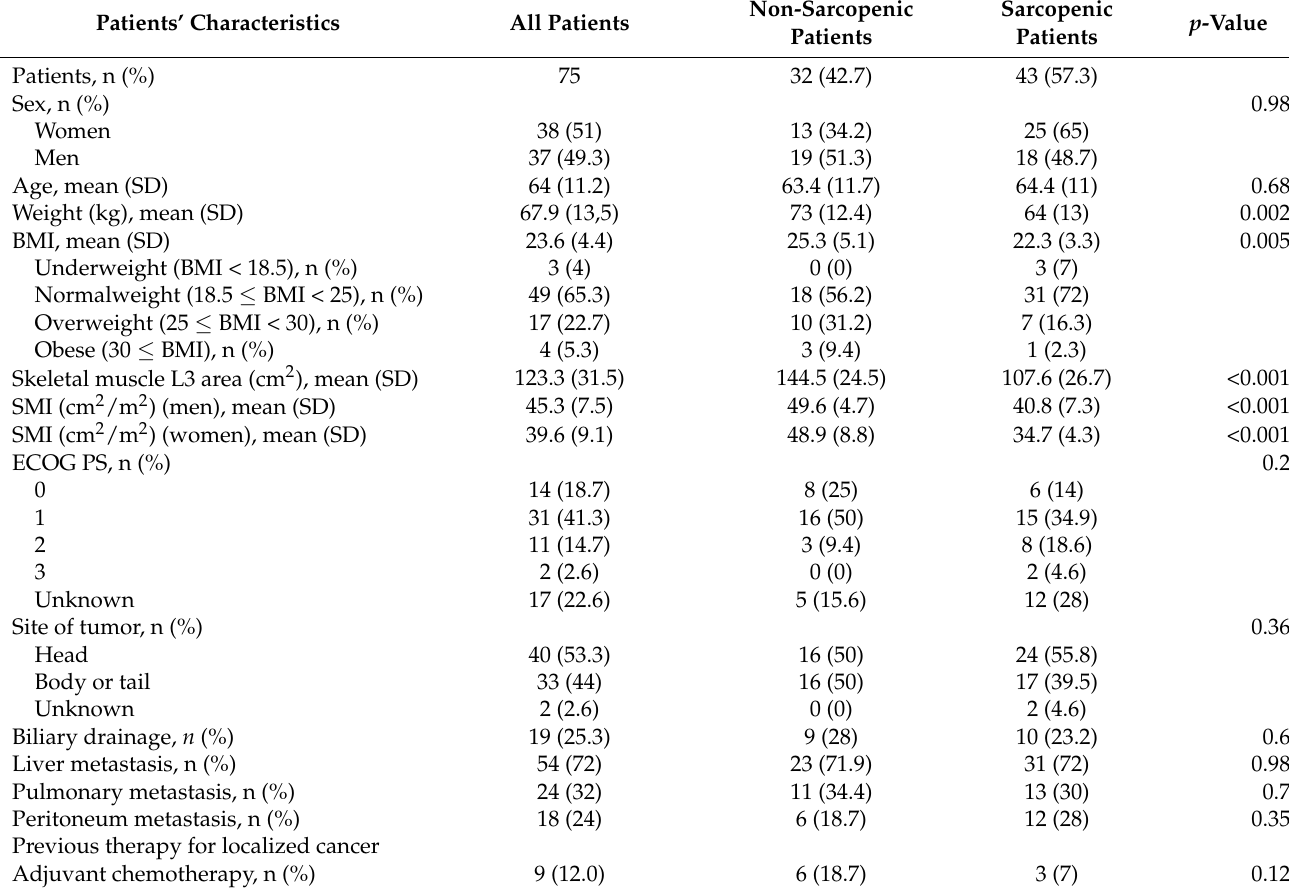
Table 1. Patients’ characteristics at baseline.